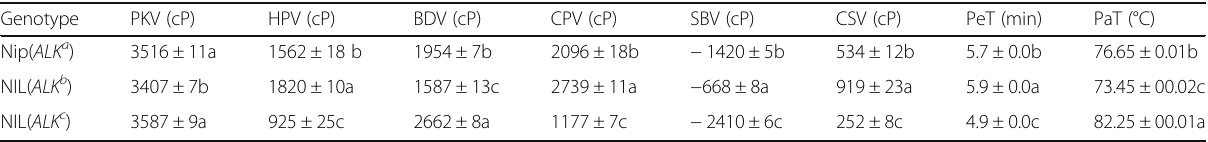
Table 2 Comparison of the pasting properties of rice starch among near-isogenic lines (NILs) a